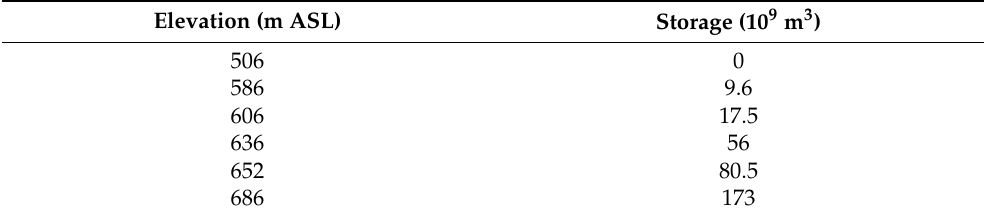
Table 1. Elevation–Storage curve data of the GERD reservoir, (after [33] ).